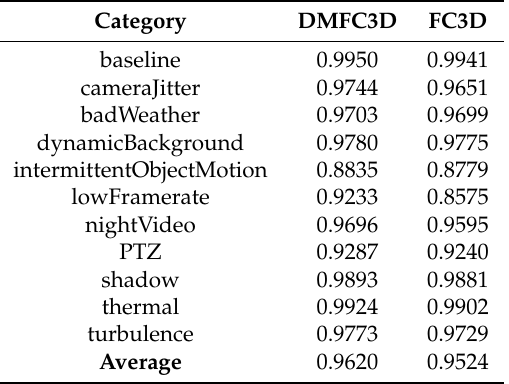
Table 3. FM metric comparison of multi-scale FC3D and single-scale FC3D over